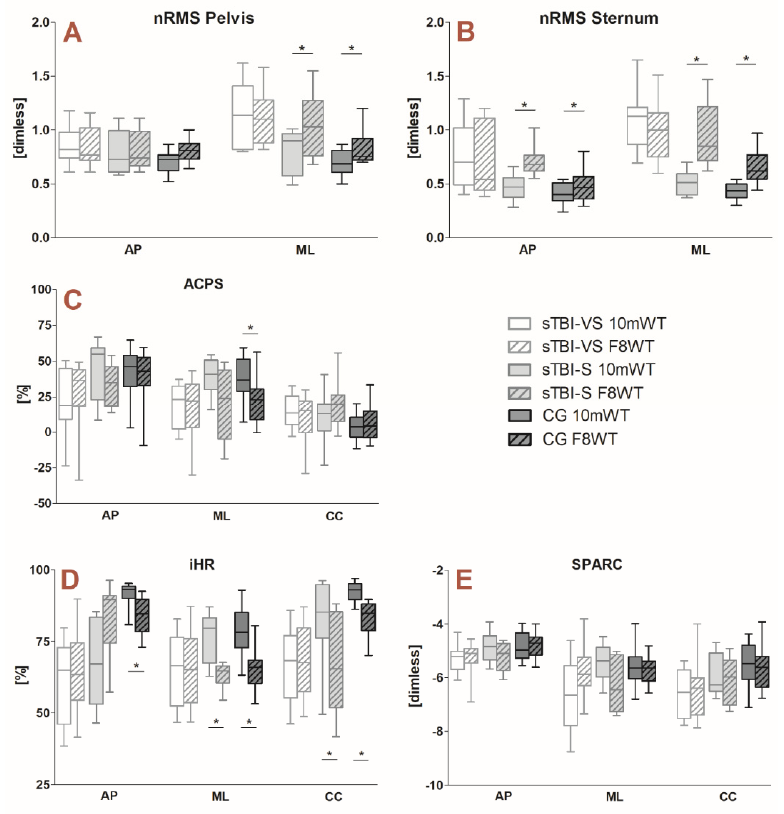
Figure 3. Whisker’s plots reporting gait quality indices for both sTBI sub-groups (sTBI-VS and sTBI-S) and for CG in the 10 mWT (solid boxes) and F8WT (striped boxes). Panel ( A , B ): normalized RMS values (nRMS) for pelvis and sternum levels, respectively; Panel ( C ): attenuation coe ffi cients (AC); Panel ( D ): improved Harmonic Ratio (iHR); Panel ( E ): SPectral ARC length (SPARC). AP, antero-posterior; ML, medio-lateral; CC, cranio-caudal; P, pelvis; S. In all plots, the horizontal lines with asterisks indicate statistically significant di ff